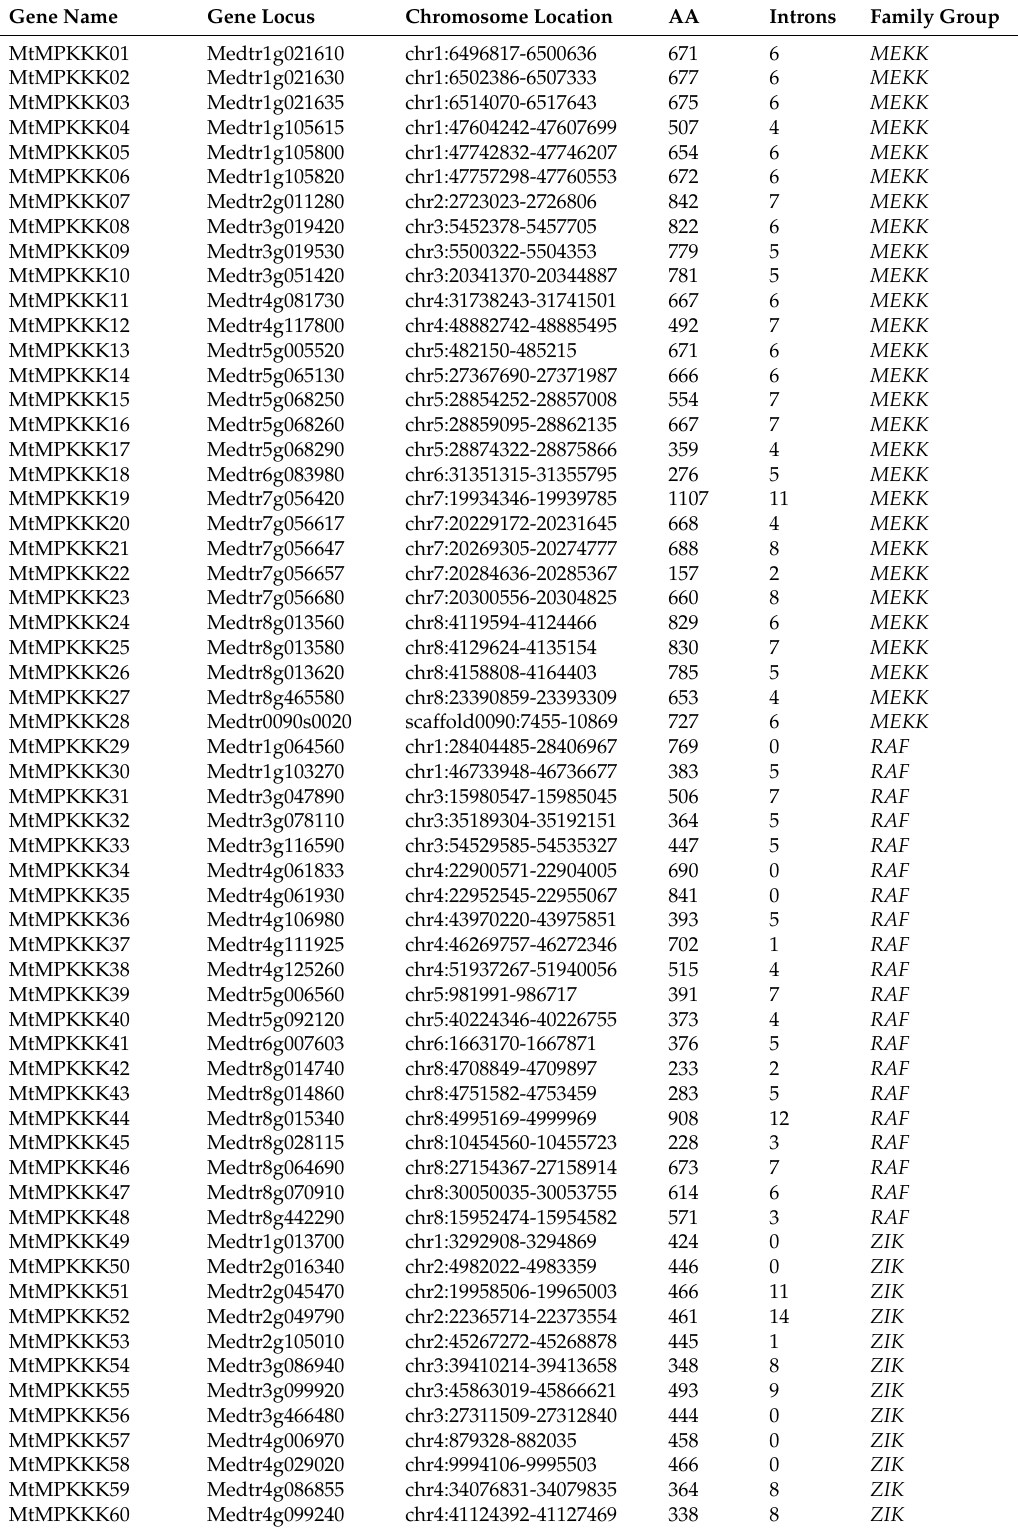
Table 1. List of all MtMAPKKK genes identified in the Medicago truncatula